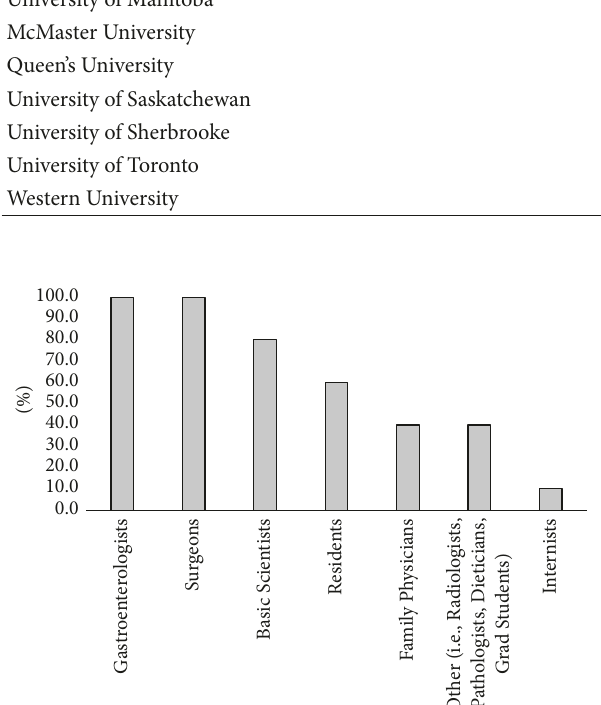
Figure1:Specialistsinvolvedintheundergraduatemedicalcurricu- lum at Canadian medical